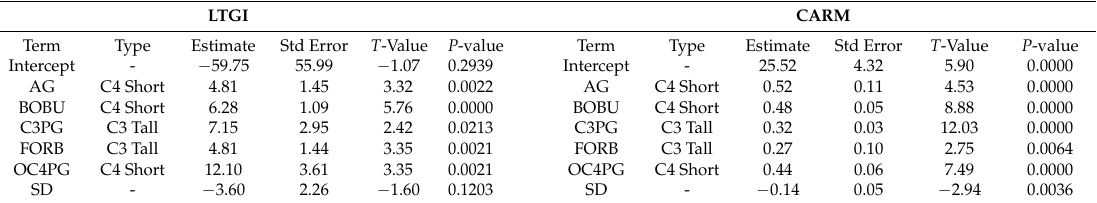
Table 2. Model results from the multiple linear regressions of plant functional groups on iAPAR for the LTGI and CARM experiments. The LTGI response variable (iAPAR) was exponentiated by 1.5 to obtain normal